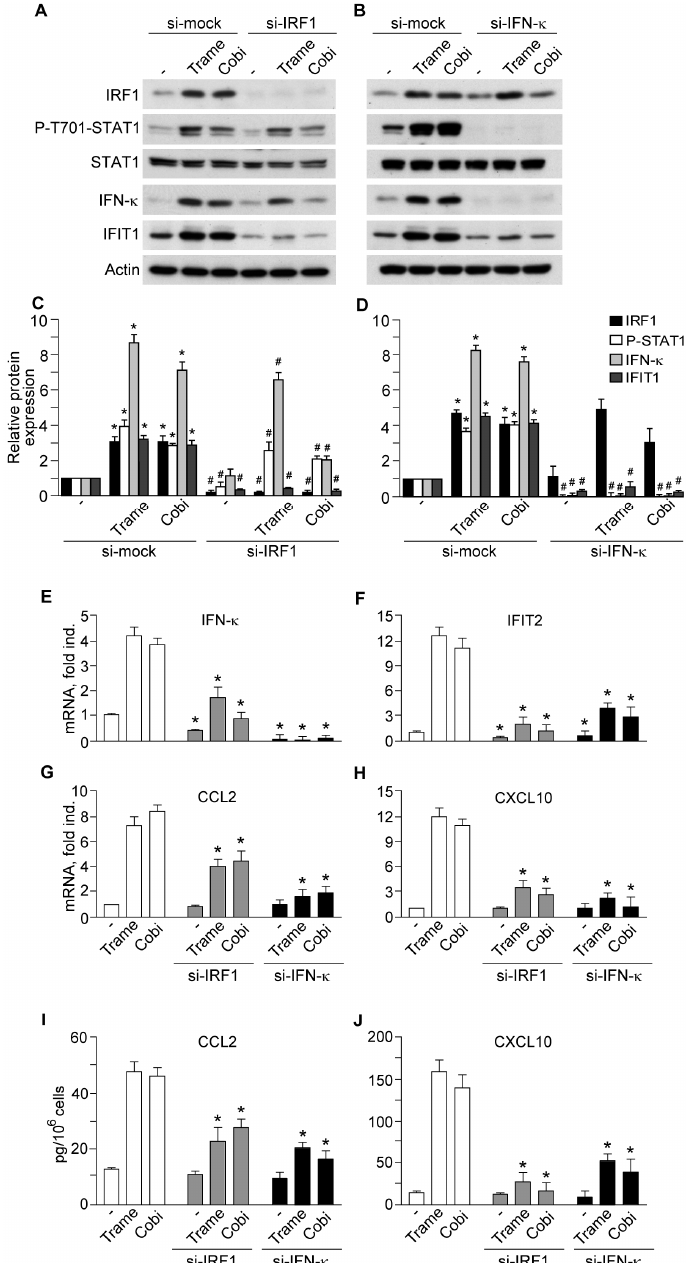
Figure 5. Activation of IRF1 and STAT1 is implicated in the enhanced expression of anti-viral effectors IFIT1 and 2, and the chemokines CCL2 and CXCL10 induced by MEK inhibitors. ( A , B ) Western blot analysis of total cell lysates of keratinocytes treated for 6 h with the MEK inhibitors Trame and Cobi (both at 100 nM) were performed after 48 h transfection with irrelevant small interference RNA (si-mock) and specific IRF1 -targeted si-RNA ( si-IRF1 ), or IFN- κ -targeted si-RNA ( si-IFN- κ ); ( C , D ) the ratios of protein expression of IRF1, P-T701-STAT1, IFN- κ and IFIT1 to their loading control (actin) were calculated. * p < 0.05 versus untreated controls ( − ); #, p < 0.05 versus same treatment (untreated controls, Trame or Cobi) in si-mock control cultures; ( E – H ) quantitative real-time RT-PCR analysis was performed in total RNA extracted from normal human keratinocytes treated for 6 h with the two distinct drugs. * p < 0.05 versus same treatment (untreated control, Trame, or Cobi) in control cultures; ( I , J ) protein quantification by ELISA of CCL2 and CXCL10 was performed on keratinocytes supernatants at 24 h. * p < 0.05 versus same treatment (untreated control, Trame, or Cobi) in control cultures. Data are indicative of experiments on cells from four different healthy donors. Data are expressed as the mean ± S.D.